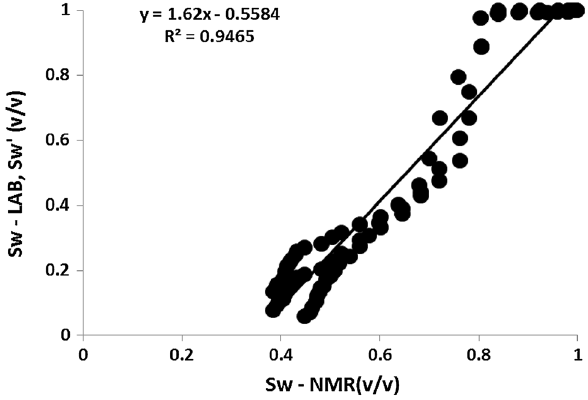
Fig. 21 S S w-LAB versus w-NMR for all samples within the channel sto- rey margin unit. The black thick line represents the average curve